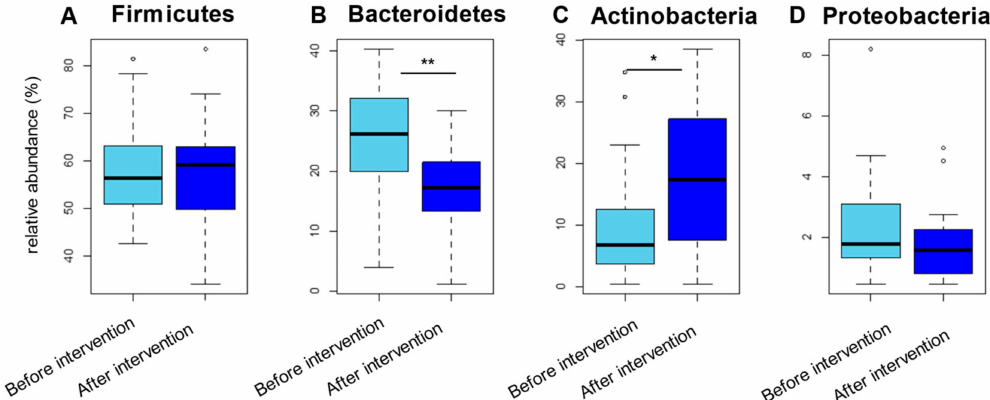
Figure 1. Alterations in the microbiome at the phylum-level associated with the intervention of acarbose. ( A ), Firmicute; ( B ), Bacteroidetes; ( C ), Actinobacteria; ( D ), Proteobacteria. Comparison of the microbial abundance at the phylum-level between the two groups (before and after the intervention of acarbose) based on 16S data. Top four abundant phyla are represented. Each box plot represents median, interquartile range, minimum, and maximum values; * p < 0.05 and ** p < 0.01, based on the paired t -test. ( A ), represents phylum Firmicutes; ( B ), represents phylum Bacteroides; ( C ), represents phylum Actinobacteria; and ( D ), represents phylum Proteobacteria.